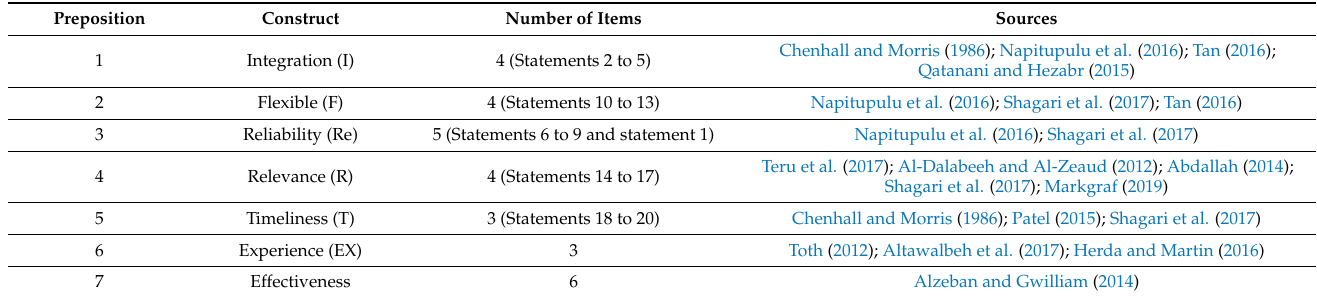
Table 1. Constructs and items adopted from (Source: authors’ compilation).